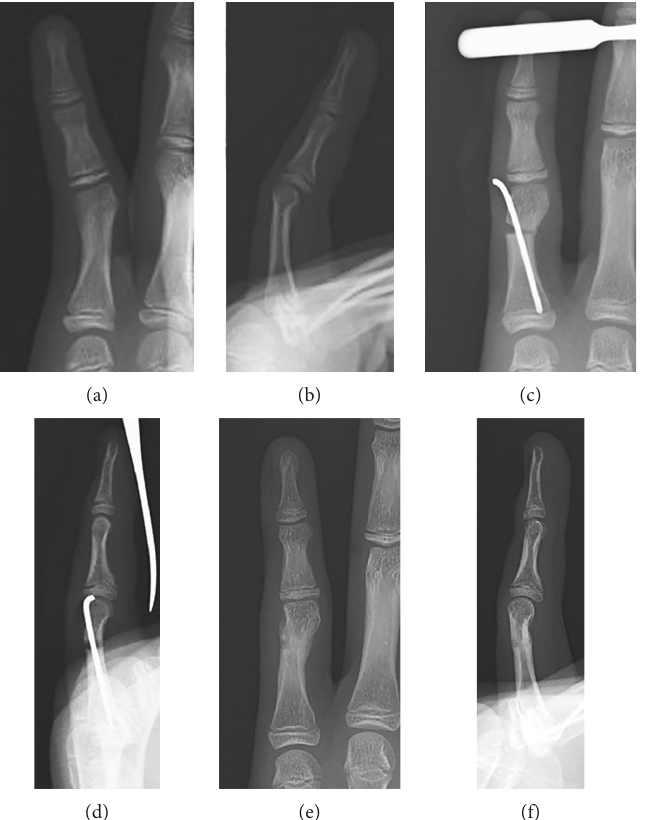
Figure 7: Radiographs of Case 2. (a, b) Preoperative radiography of the left little finger. (c, d) Images taken immediately after the surgery. (e, f) Images taken 3 months